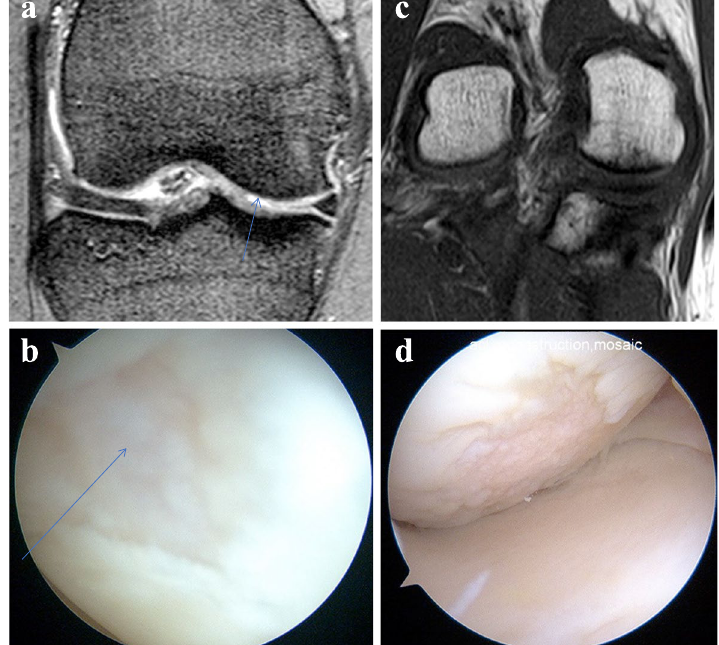
Fig. 1 a The unevenness of articular cartilage with effusions in T2-weighted sequences in the right medial femoral condyle (arrow). b The arthroscopic view. The arrow showed cartilage injury in MFC. c The irregularity of subchondral bone in T1-weighted sequences in the right medial femoral condyle. d The arthroscopic